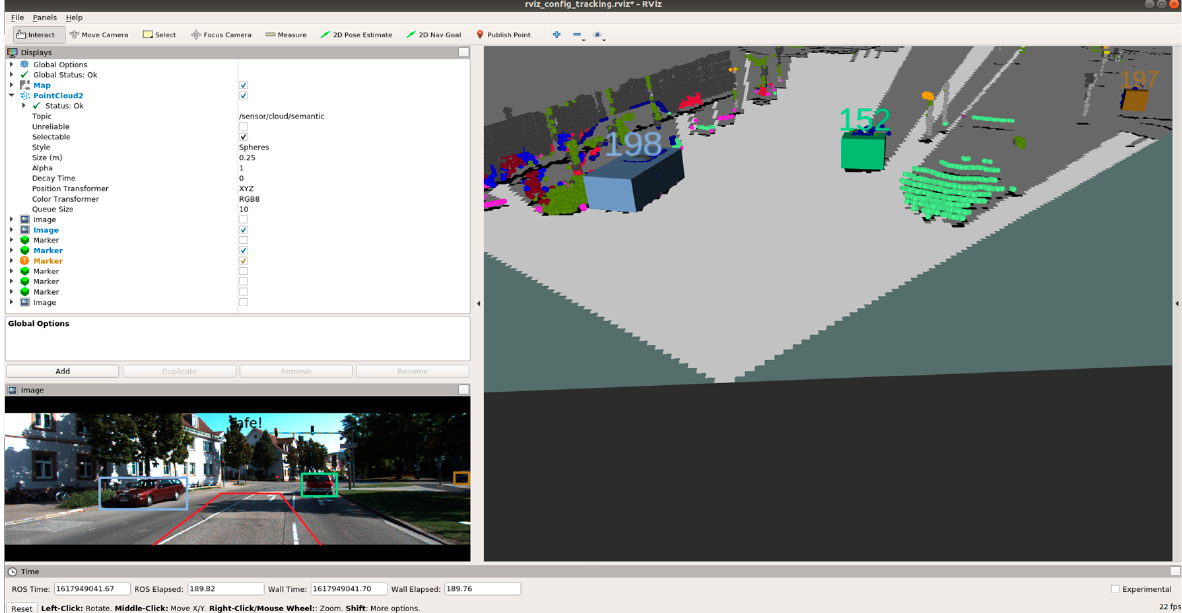
Figure 24. Safe scenario as detected by ODSF-driven EBA (object IDs are depicted above the 3D bounding boxes).